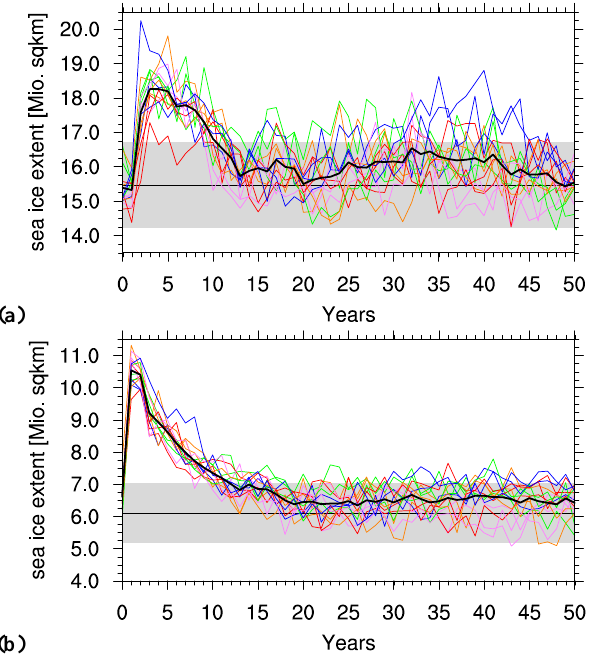
Fig. 7. Time series of global sea ice extent in (a) March and (b) September in 10 6 km 2 . Colours as in Fig. 2.